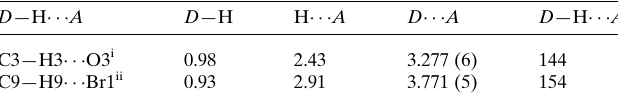
Table 1 Hydrogen-bond geometry (A˚ , (cid:2) ).